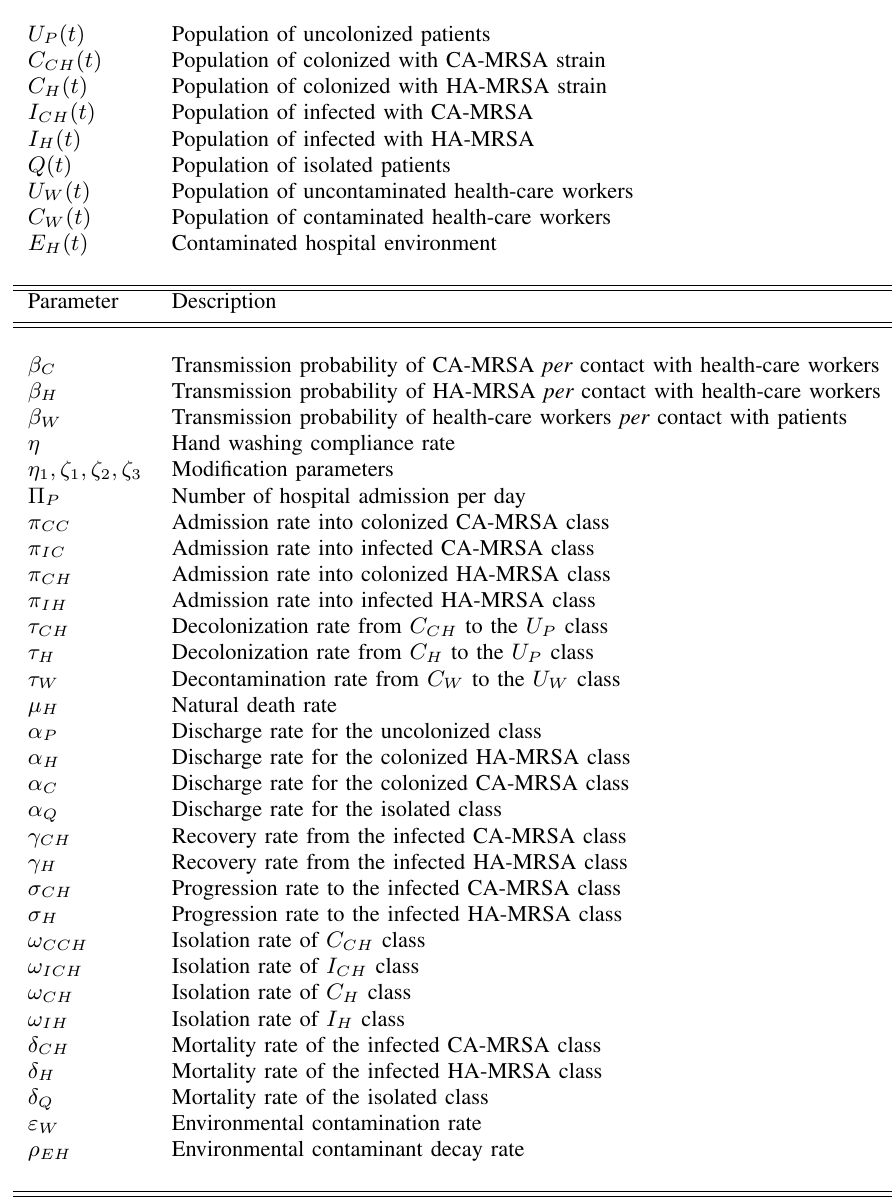
V ARIABLES AND PARAMETER DESCRIPTIONS OF MODEL